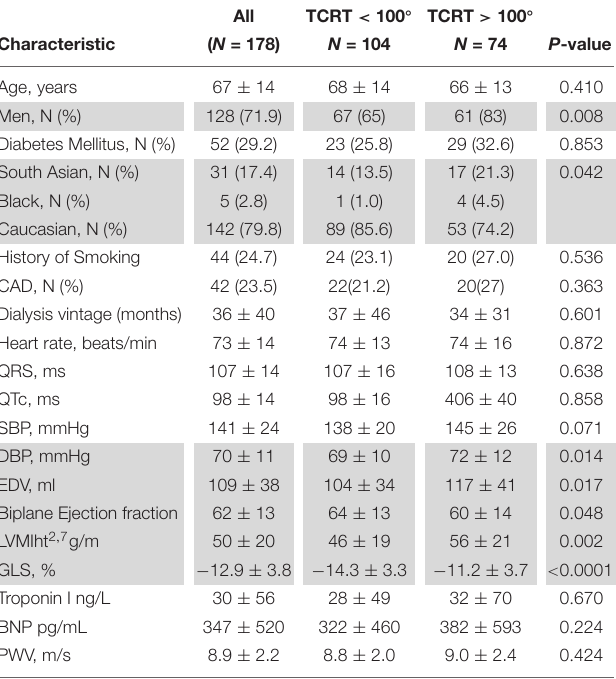
TABLE 1 | Baseline characteristics of the study participants according to